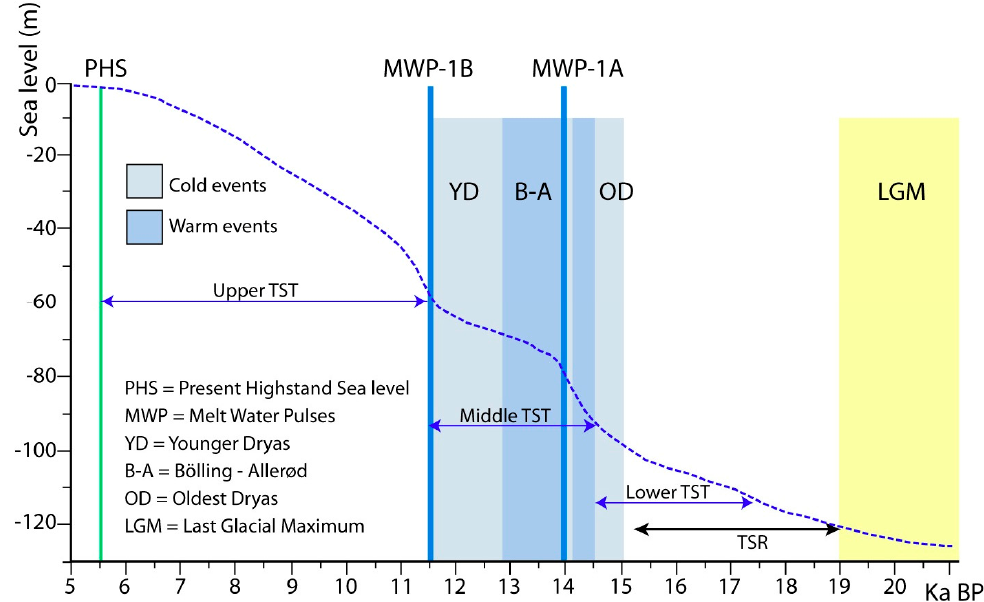
Figure 11. The relationship between climate events controlling the shape of the sea level curve and the time of deposition of TST units in the Central Adriatic (blue double arrows) has been reconstructed by [45,73], and extended to the South Adriatic by [66]. The interval of deposition of the TSR deposits is constrained on the basis of their bathymetric depth and stratigraphic position with respect to other TST units and the LST deposits of the Last Glacial Maximum (LGM).